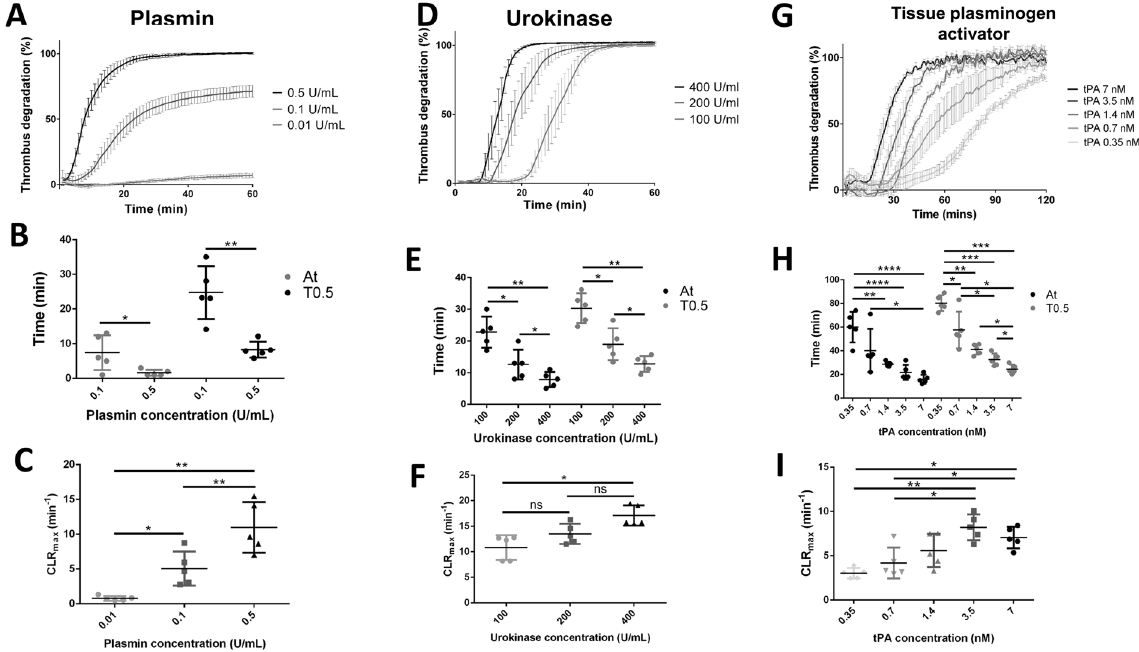
Figure 2. Thrombolysis study with plasmin, urokinase and tissue plasminogen activator (t-PA). Thrombolysis profiles measured with the Halo assay method with 0.5 U/mL, 0.1 U/mL and 0.01 U/mL plasmin ( A ), with 400 U/mL, 200 U/mL and 100 U/mL urokinase ( D ) and with 0.35 nM, 0.7 nM, 1.4 nM, 3.5 nM and 7 nM t-PA ( G ). Activation times (At, black spots) and time to 50% lysis (T0.5, grey spots) ( B , E and H ) and maximal clot lysis rates ( C , F and I ) were presented for each concentration as mean values ± SD (n = 5, ns: not significant, * p < 0.05, ** p < 0.01, *** p < 0.001, **** p <